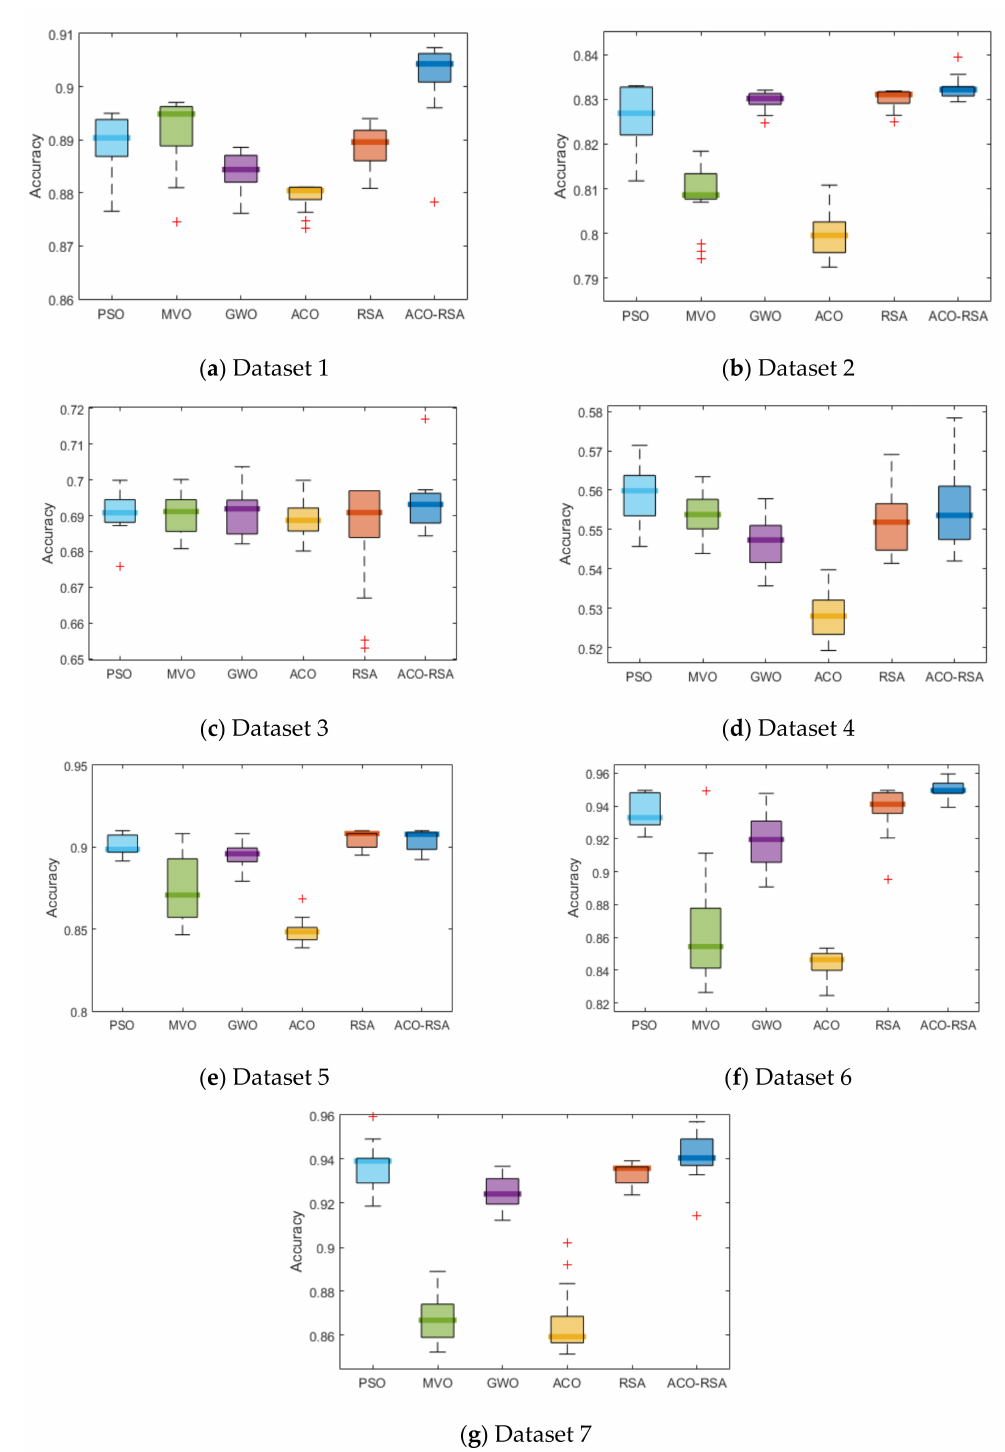
Figure 6. The boxplot graphs of each MA for each